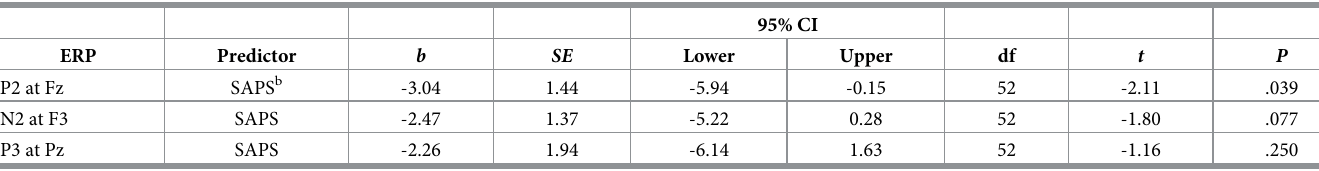
Table 9. Overall P2, N2, and P3 as a function of individual differences in smartphone addiction. 95% CI ERP Predictor b SE Lower Upper df t P P2 at Fz SAPS b -3.04 1.44 -5.94 -2.11 .039 SAPS -1.16 .250 ERP amplitudes (in microvolts) on the oddball task as a function of individual differences in smartphone addiction. ERPs were time-locked to the presentation of the visual stimulus. a N2 is a negative going potential, thus smaller values indicate larger ERP amplitude. b SAPS = Smartphone Addiction Proneness Scale (mean centered). Dependent variable = ERP mean amplitude. CI = Confidence